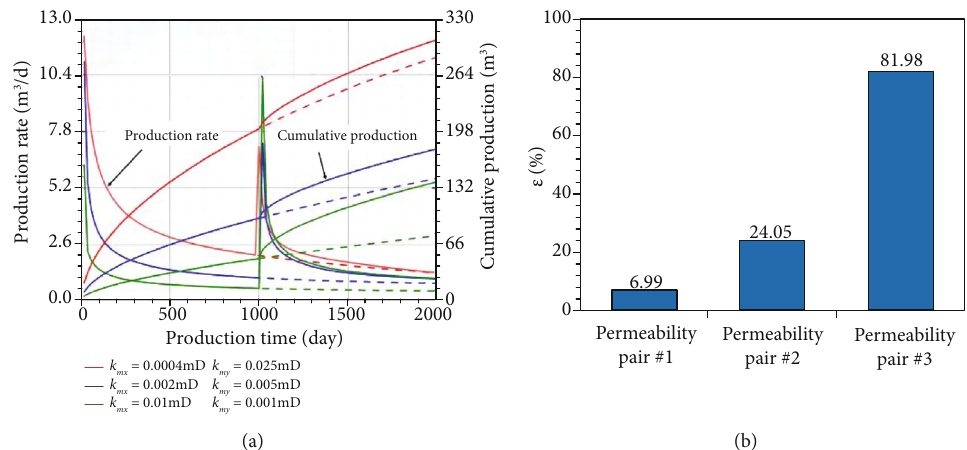
Figure 3: Performance of the refracturing treatment with di ff erent permeability anisotropies: (a) production rate and cumulative production and (b) comparison of the increase ratio.